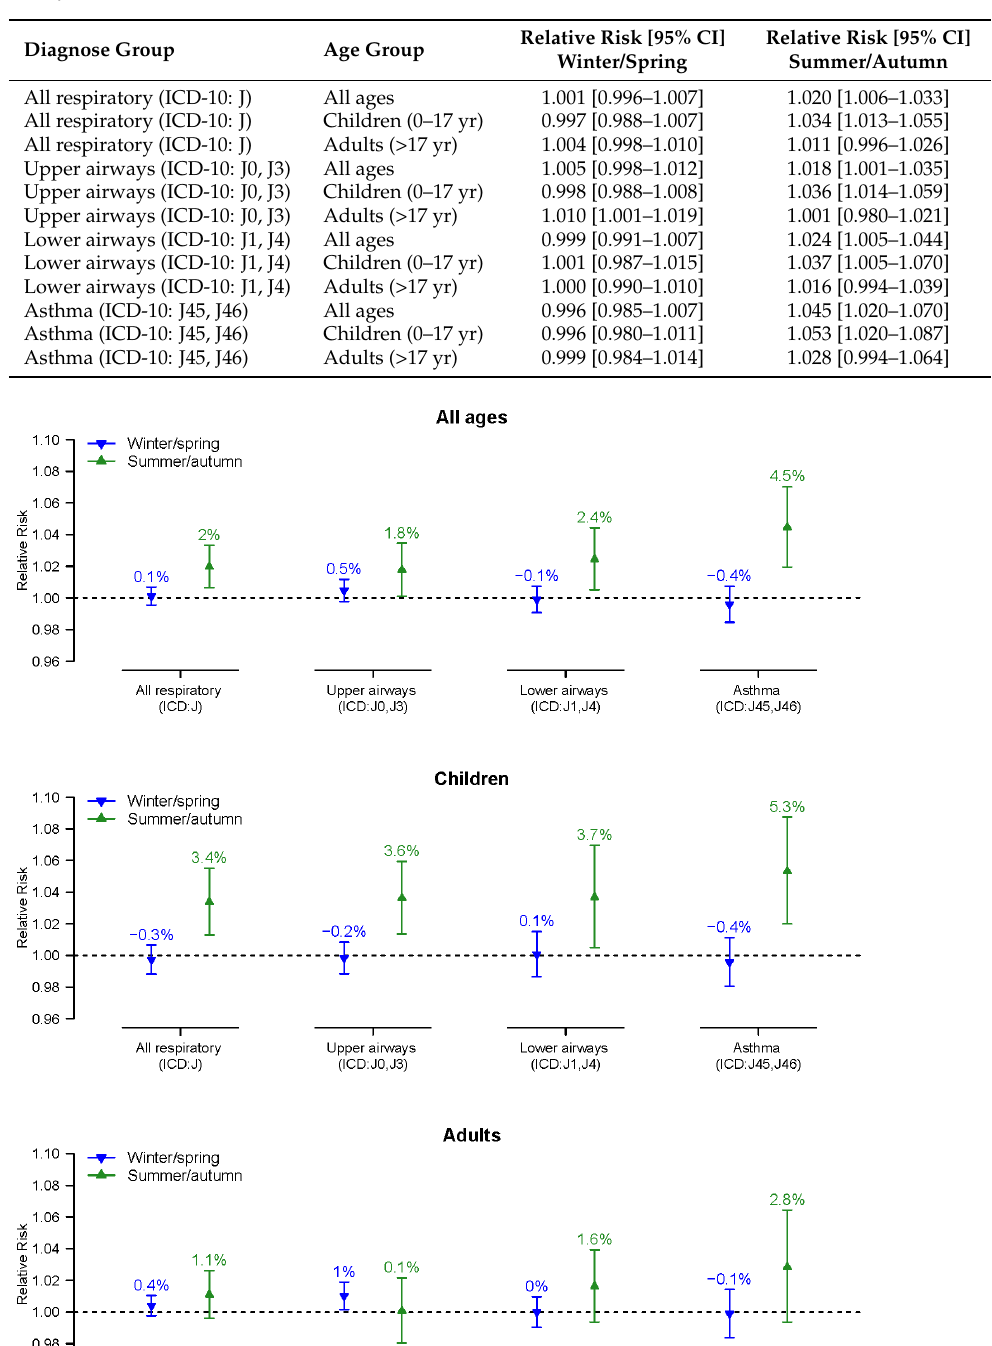
Table 3. Relative risk of a 10 µ g m − 3 increase in PM 10 for the studied age and diagnose groups registered at all healthcare facilities in Visby divided into all ages, children (0–17 years), and adults (>17 years).